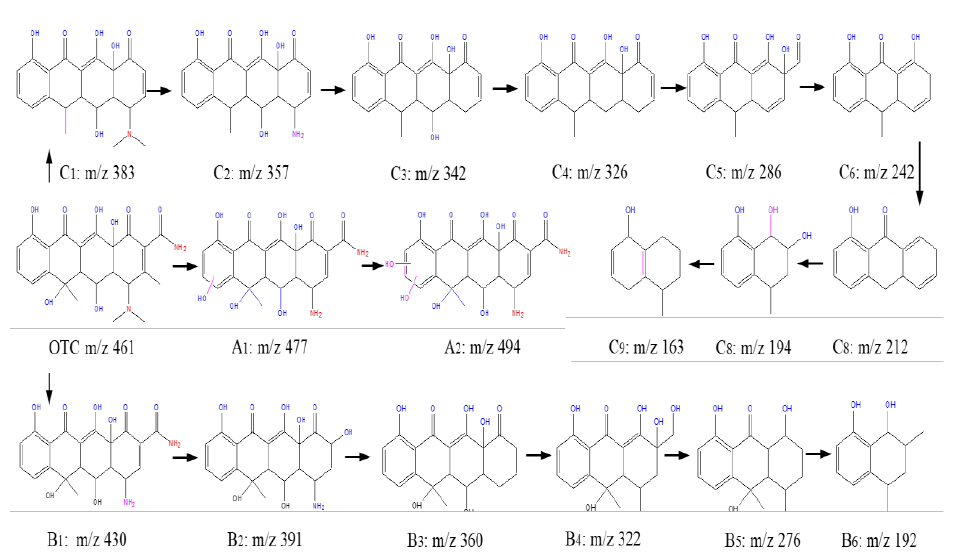
Figure 9. Proposed degradation pathways of OTC in nZVI/B6@BC suspension.